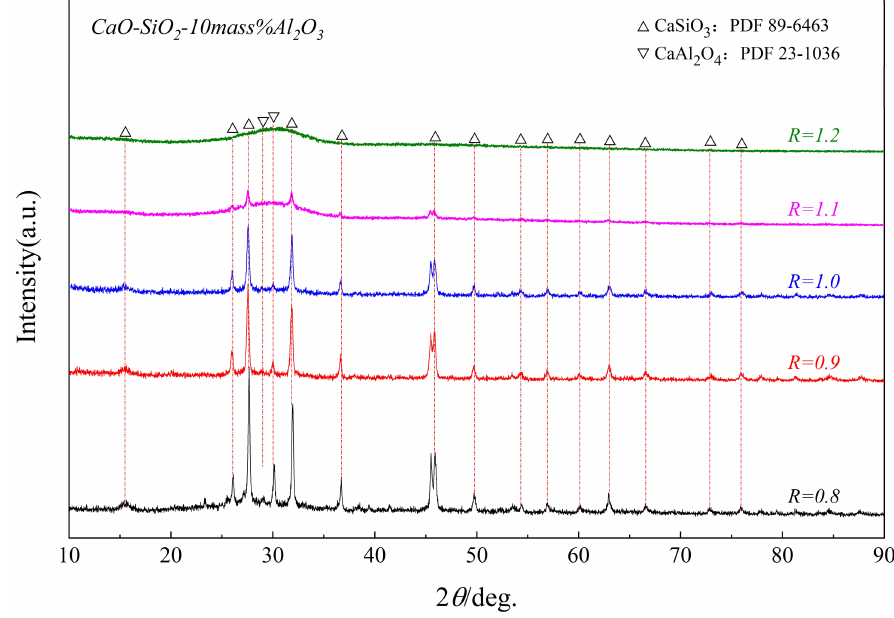
Figure 7. XRD patterns of samples with different R glass phases after being held at a constant temperature of 950 ◦ C for 1